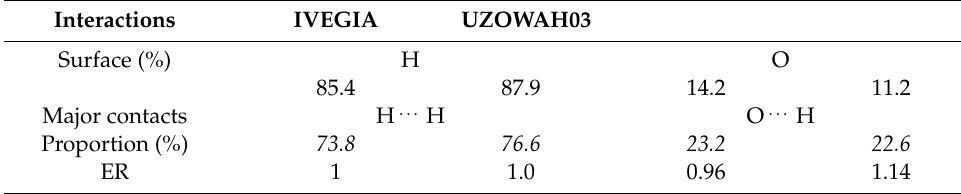
Table 2. Major interactions, proportions on the HS and ER for perindopril